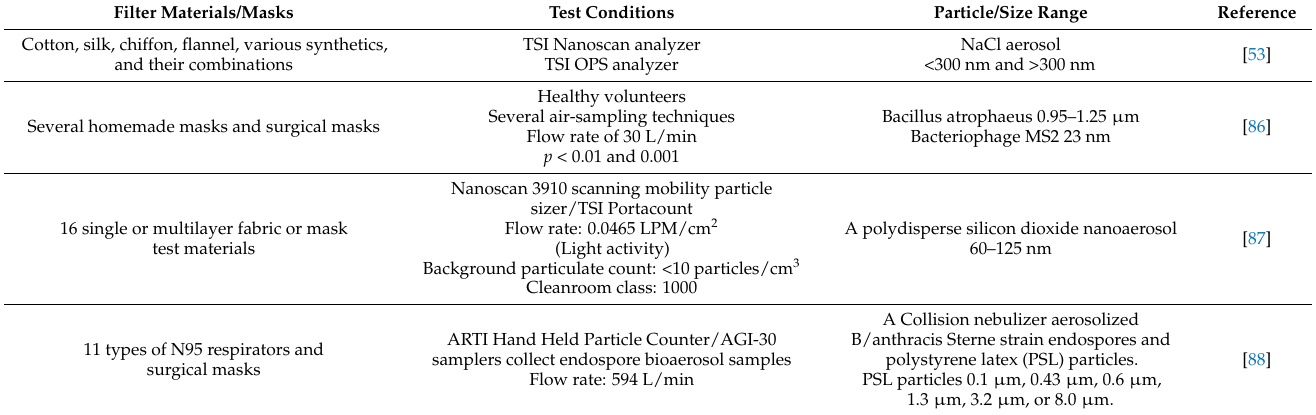
Table 2. A summary of some experimental studies on filtration performance